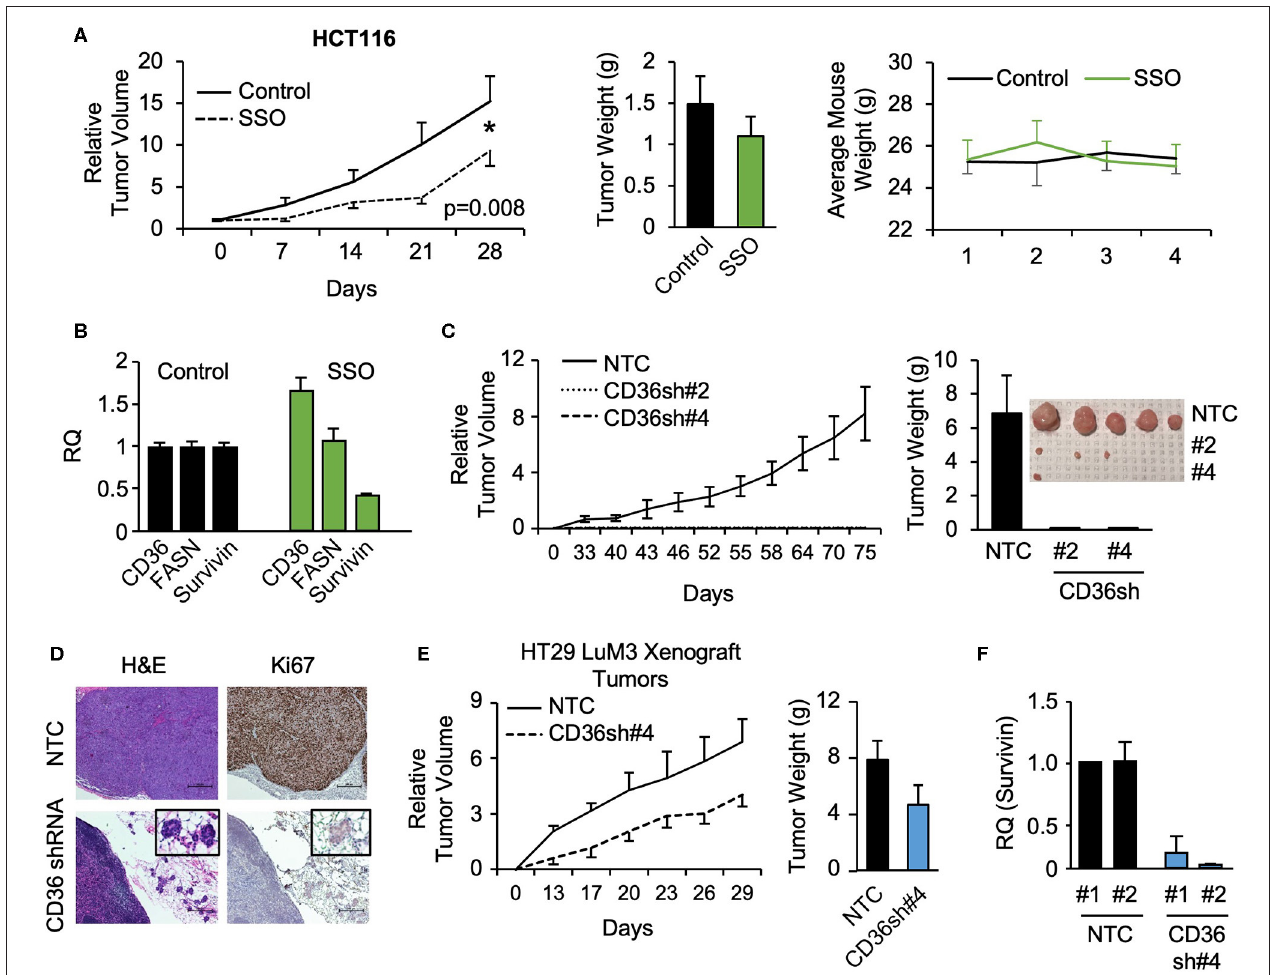
FIGURE 4 | SSO treatment and CD36 knockdown inhibit tumor growth in vivo . (A) Tumor volume, tumor weight, and mouse weight of control and SSO treated (20 mg/kg) mice are shown. SSO was dissolved in 10% PEG and administered in 200 µ l dosages via oral gavage daily. 1.0 × 10 6 cells were injected into NU/NU mice. Treatment was initiated when tumors reached ∼ 100 mm 3 (day 0). (B) RT-PCR analysis of HCT116 tumors showing the effect of SSO treatment on CD36, FASN, and survivin mRNA expression. (C) Tumor volume of HCT116 NTC and CD36 shRNA #2 and #4 xenografts is shown. 1.0 × 10 6 cells were injected into NU/NU mice